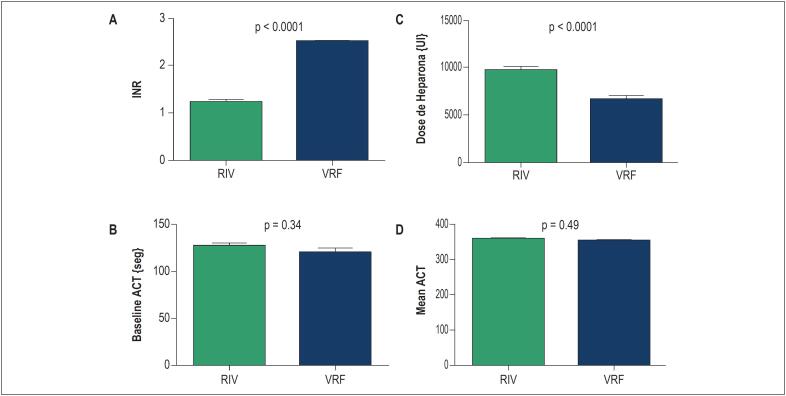
Results: Secondary outcomes related to anticoagulation level monitoring. A - Preoperative International Normalized Ratio (INR); B - Baseline ACT (activated clotting time), measured after the first venipuncture; C – Mean dose of intravenous heparin used throughout the procedure; D – Mean ACT during the procedure.